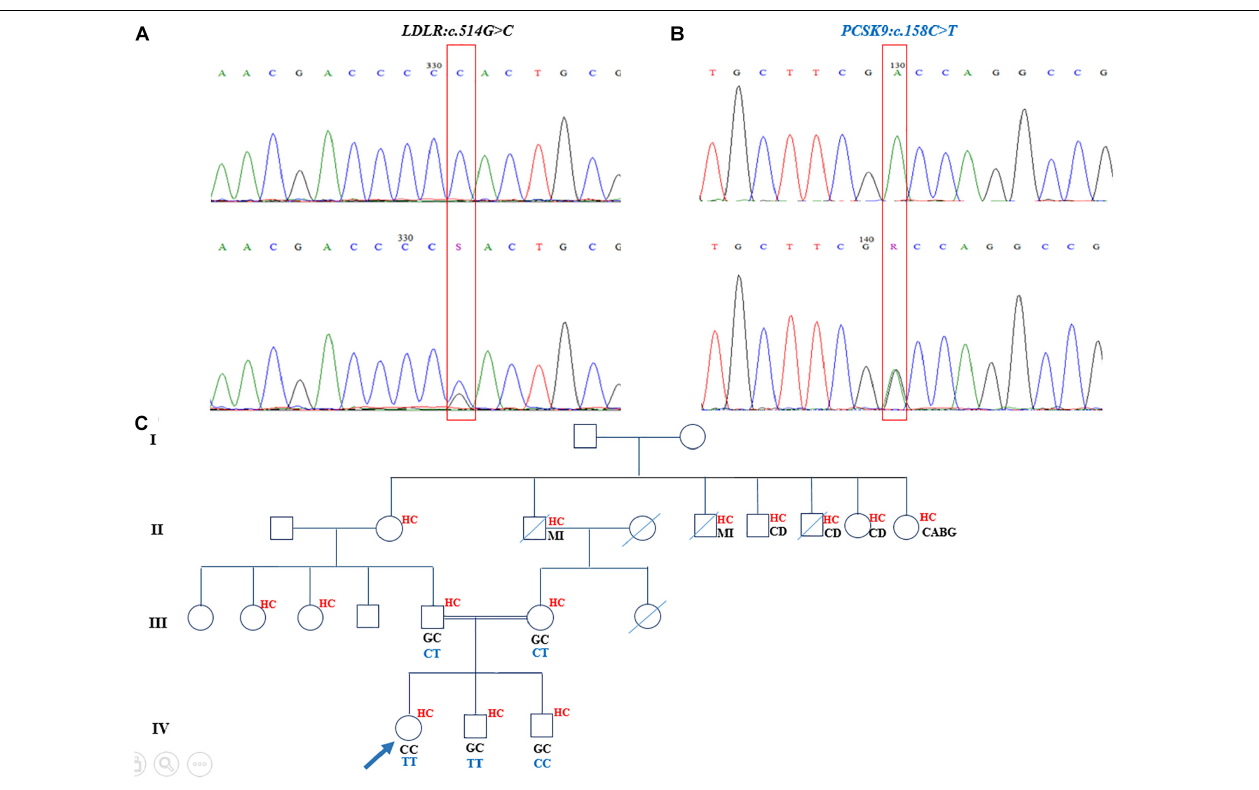
FIGURE 2 | Sequencing analysis and pedigree of proband who had double mutations in LDLR and PCSK9 genes. (A) The homozygote and heterozygote nucleotide changes at c.514G > C in LDLR demonstrated in upper chromaogram and lower chromatogram, respectively. (B) The loss-of-function mutation of PCSK9 in homozygote and heterozygote states depicted correspondingly in upper panel and lower panel. (C) The genotype of proband and her family members for LDLR and PCSK9 nucleotide changes demonstrated, respectively, in black and dark blue in the pedigree. The family history of proband exhibited positive history of hypercholesterolemia and cardiovascular diseases and myocardial infarction. The mother and father of the proband are first cousins. MI, myocardial infarction; HC, hypercholesterolemia; CD, cardiovascular diseases; CABG, coronary artery bypass